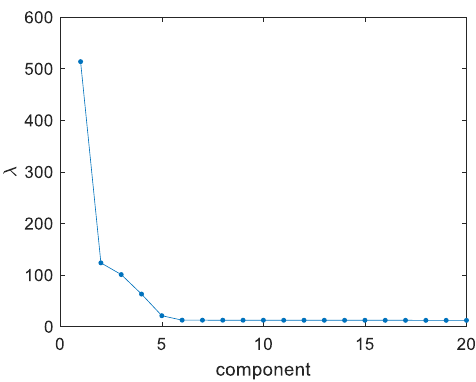
Figure 7. Scree plot of the first 20 eigenvalues of the PCA model.